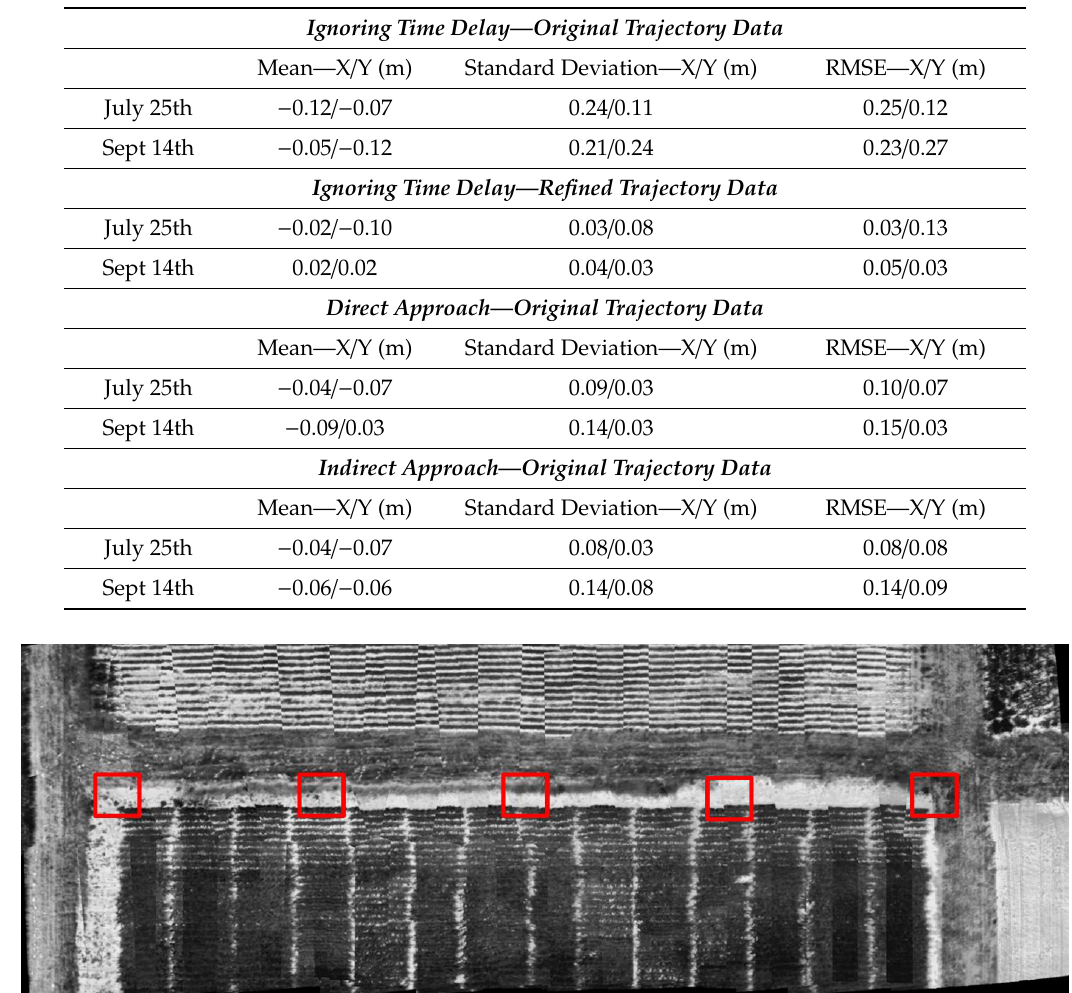
Figure 17. Orthophoto result while ignoring the time delay using the original trajectory data for FLIR thermal July 25th data collection (red boxes show the location of the check points, Orignal Image GSD ≈ 0.03 m